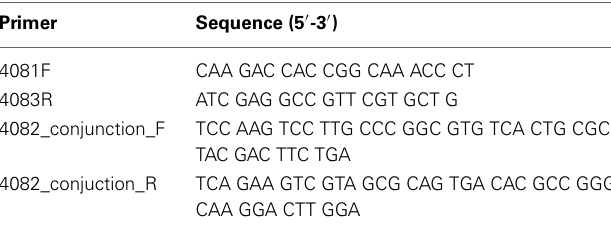
Table 3 | Strains and plasmids used for in-frame deletion of PputGB1_4082 in this